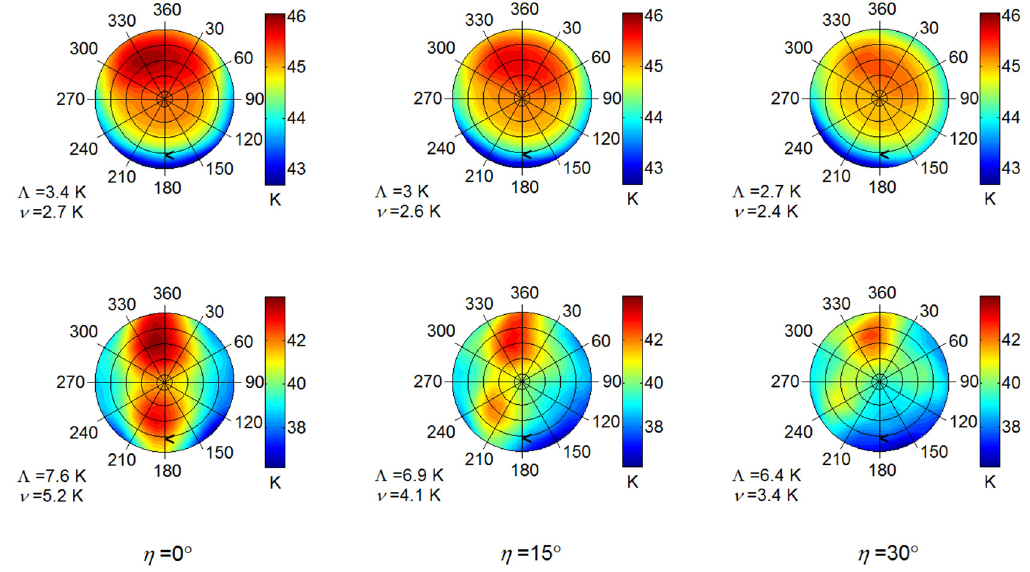
Figure 5. Example polar plots of TUF3D-SUM simulated effective anisotropy, for two neighbourhood geometries (top row: λ P = 0.32, H/L = 0.4, H/W = 0.6; bottom row: λ P = 0.31, H/L = 1.6, H/W = 2.0) and three street directions, at 1200 LST 21 June at a latitude of 60° (solar zenith angle = 36.5°). Concentric circles are, from center, off-nadir angles of 5°, 15°, 25°, 35°, and 45°. Labelled radial lines refer to azimuthal angle. The vertex of the black, bold “ < ” indicates the position of the sun.